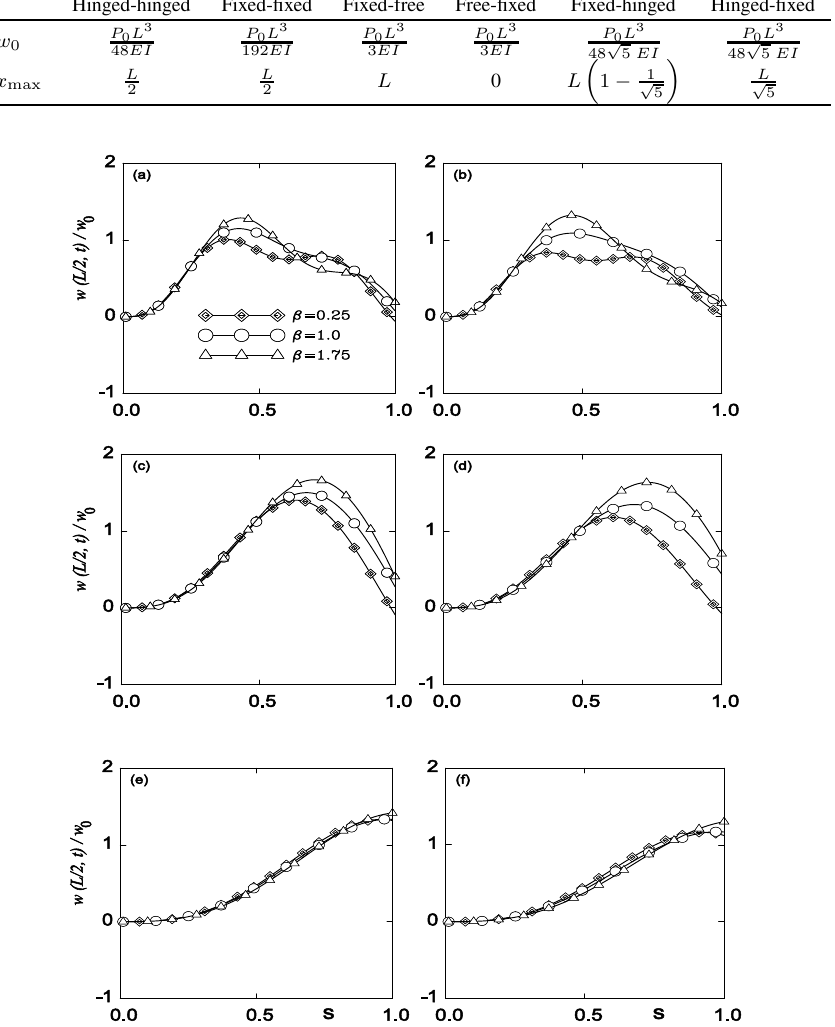
Fig. 2. Dynamic response ( w ( L 2 , t ) /w 0 ) for a hinged-hinged beam: (a) α = 0.25, ζ n = 0.1, (b) α = 0.25, ζ n = 0.2, (c) α = 0.5, ζ n =